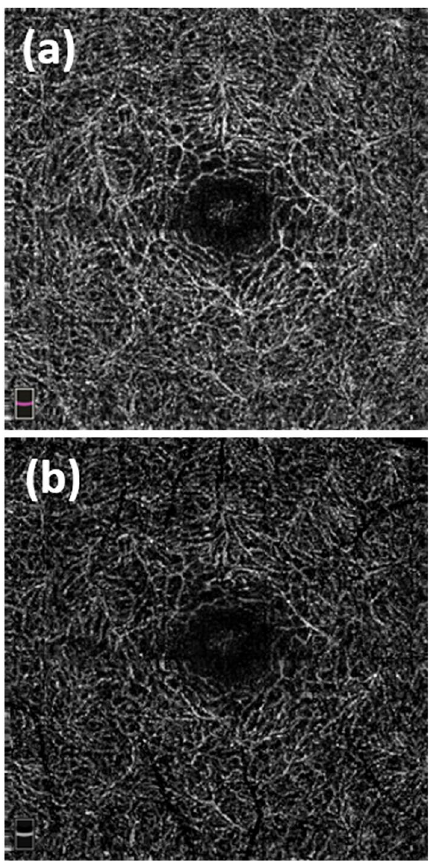
Figure 1. OCTA image of deep layer (3 × 3 mm). ( a ) Original image exported from OptoVue. ( b ) Deep layer after removal of projection artefacts from the superficial layer. OCTA Optical coherence tomography angiography.